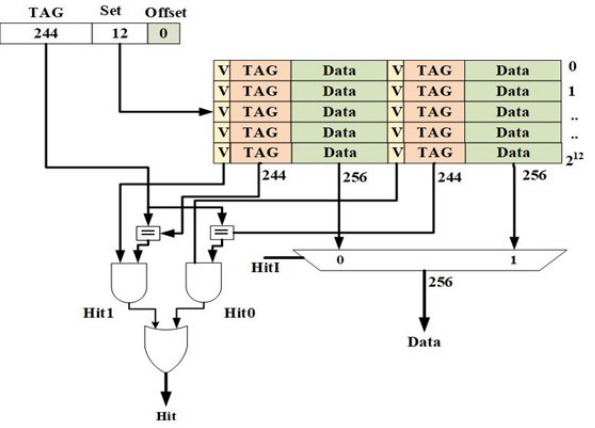
Figure 10. Two-way set-associative cache